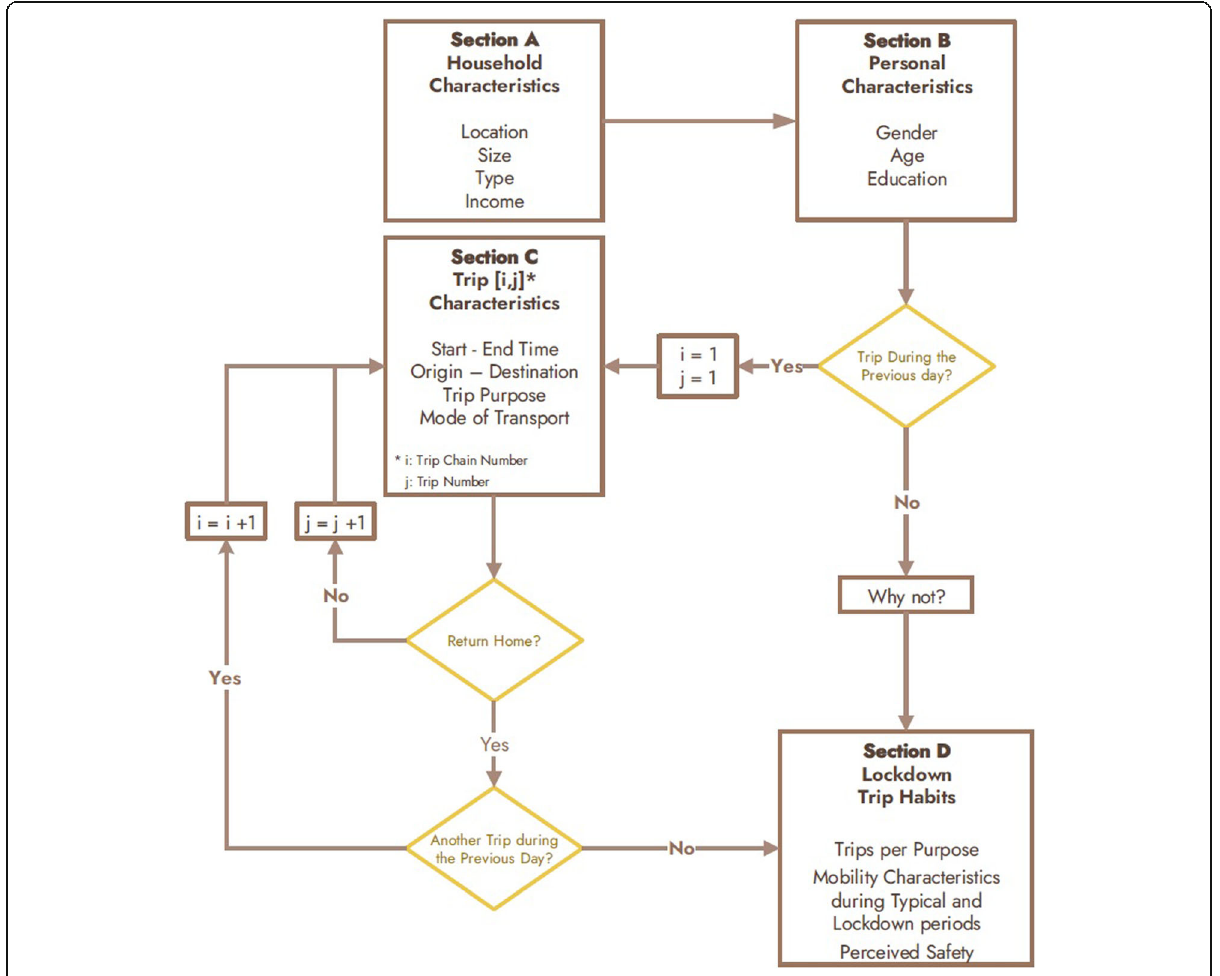
Fig. 2 Flow chart of survey ’ s